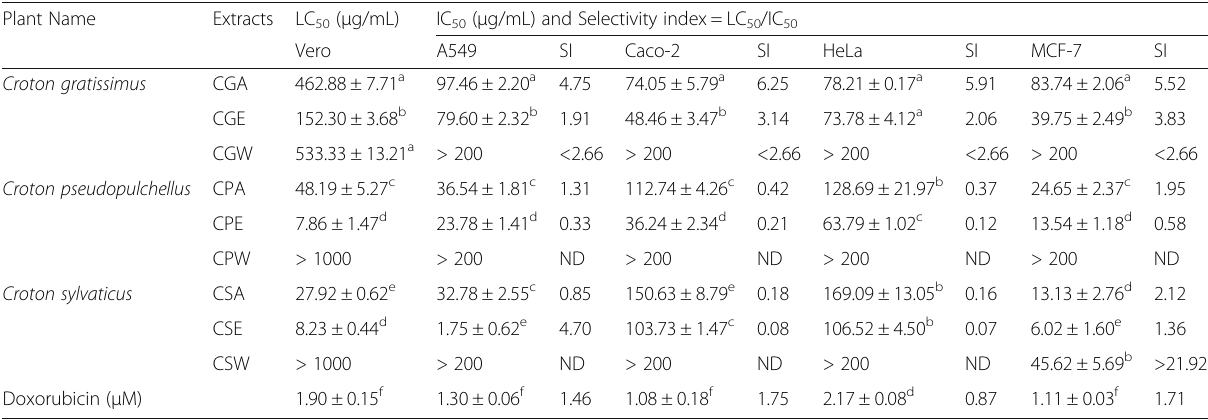
Table 3 Cytotoxic effect (IC 50 and LC 50 ) and the selectivity index (SI) of different extracts from Croton species and reference drug (doxorubicin hydrochloride) on cancerous cell lines versus a non-cancerous cell line Plant